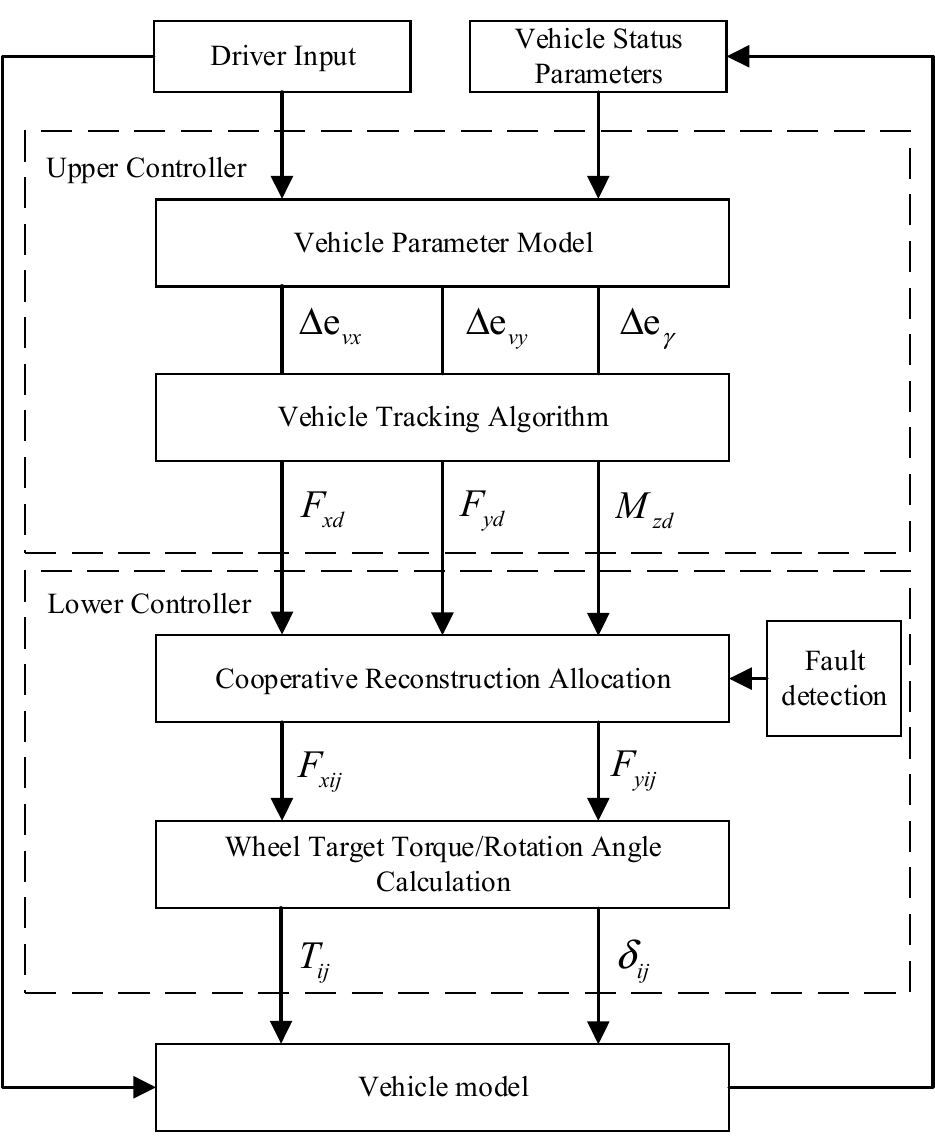
Figure 1. Overall workflow of the fault-tolerant control system.